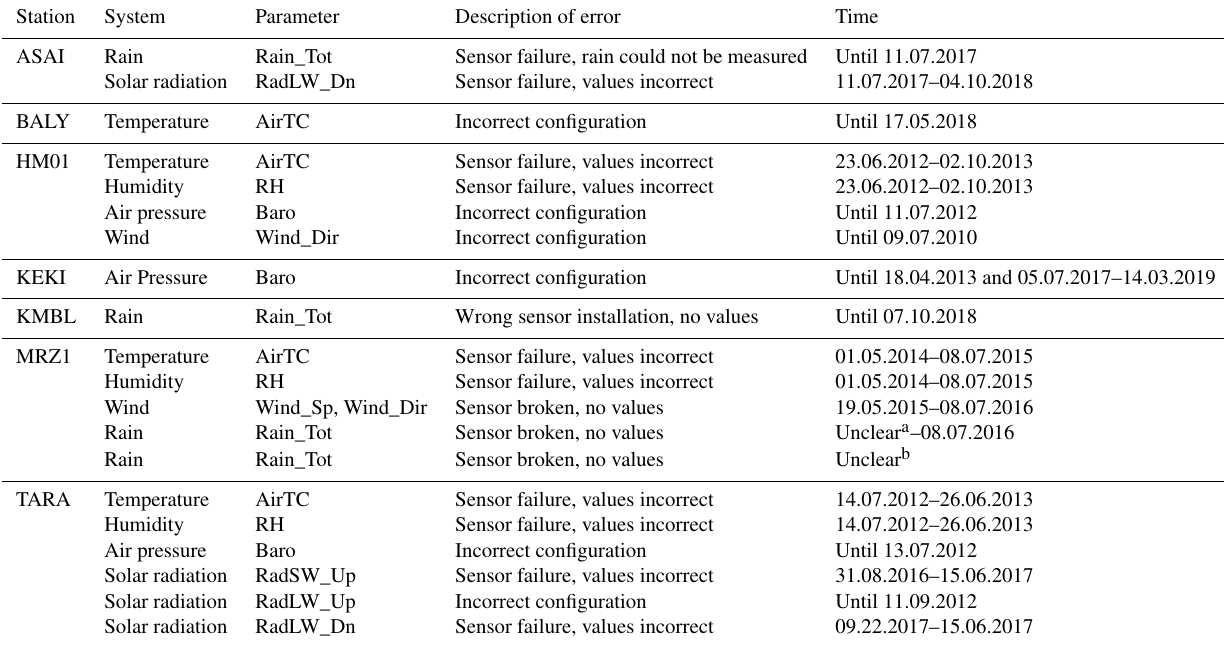
Table 8. List of problems in the meteorological data. Station